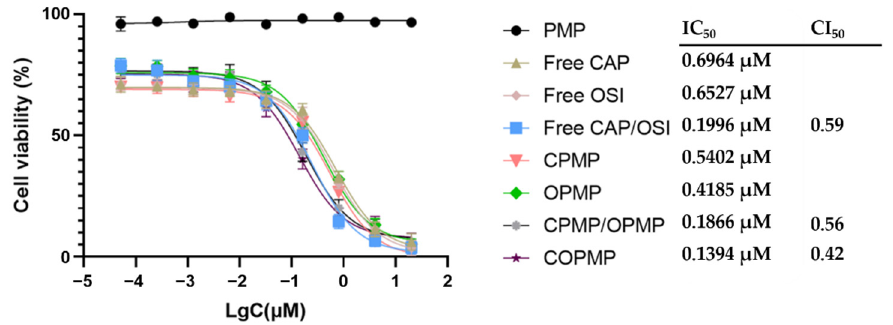
Figure 3. The IC 50 of different administration groups ( n = 3, mean ± SD).